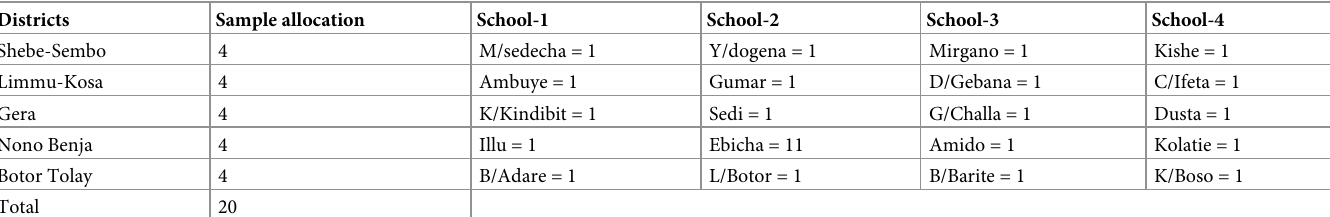
Table 1. Sampling distribution poems produced at primary schools, target districts, Jimma zone, Oromia, Ethiopa, 2020.